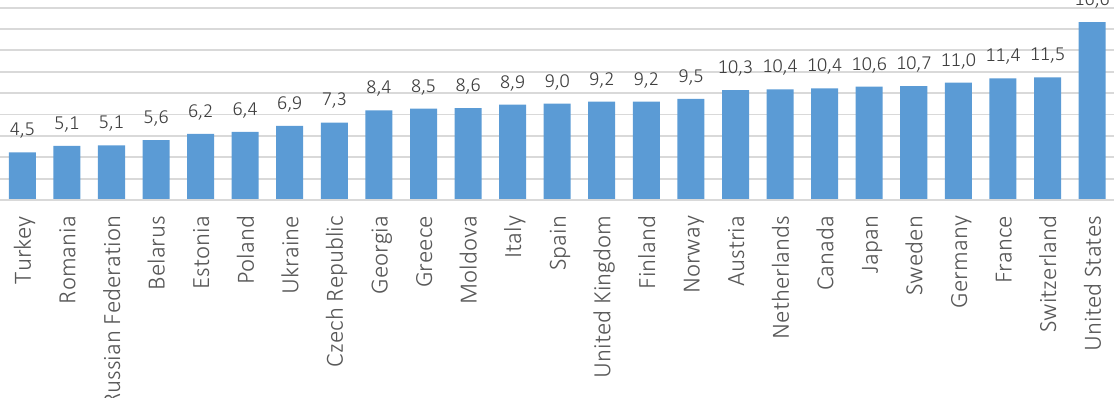
Figure 2. Average current health expenditures (2010–2017), % of GDP